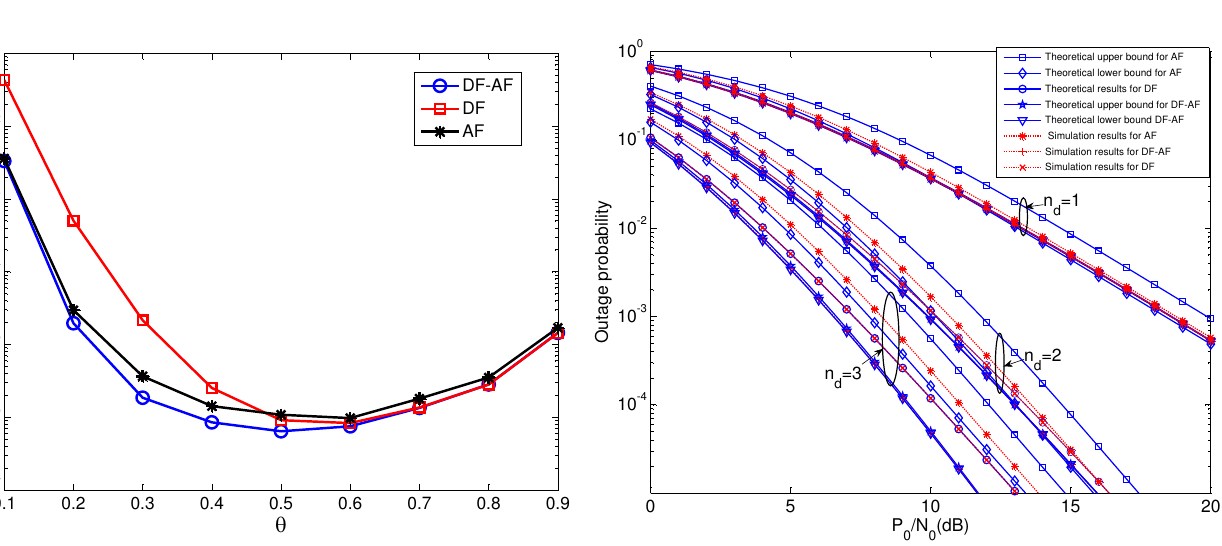
Figure 6. Outage probability performance of Alamouti code in Nakagami- m keyhole environments with fading parameters = 2 , m = 3 , m = 2 and all other fading parameters m h h 22 g 22 21 equal to 1